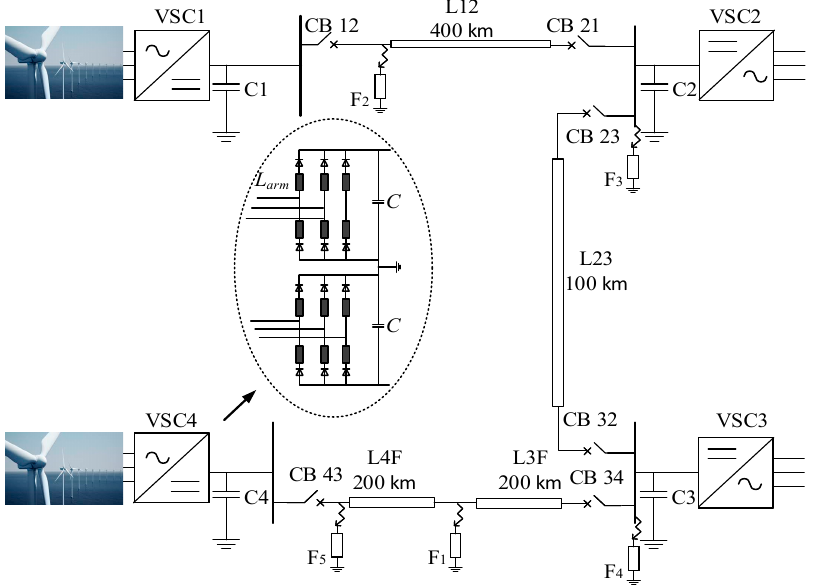
Figure 4. Multi-terminal high voltage direct current network layout indicating voltage-source converter (VSC)-based converter topology. Table 2. System parameters.